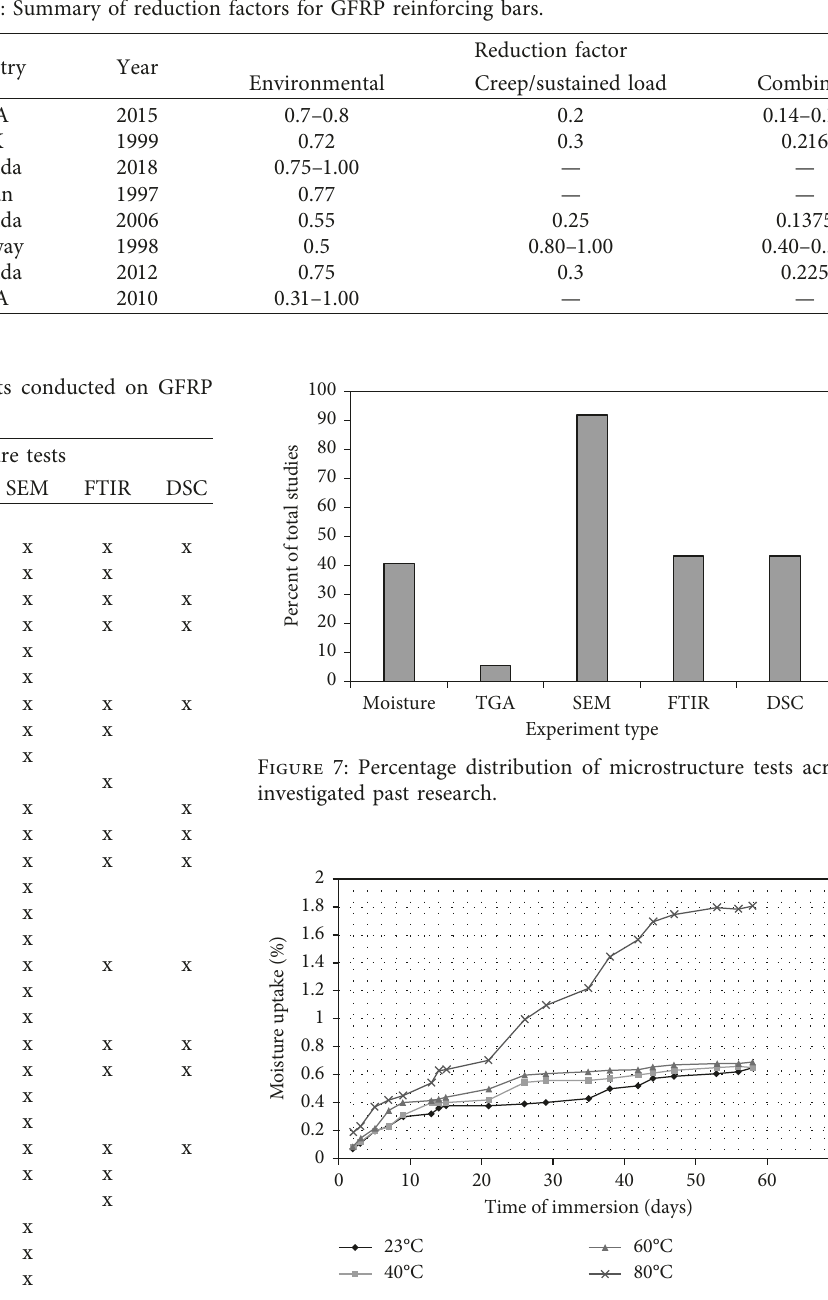
Figure 8: Typical moisture uptake curve of GFRP bars (adapted from